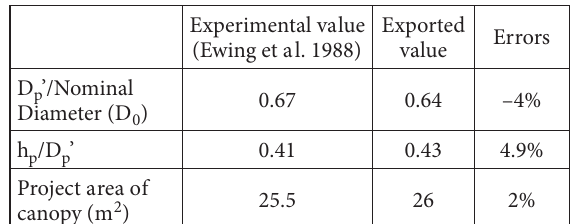
Table 5. Comparison of geometry